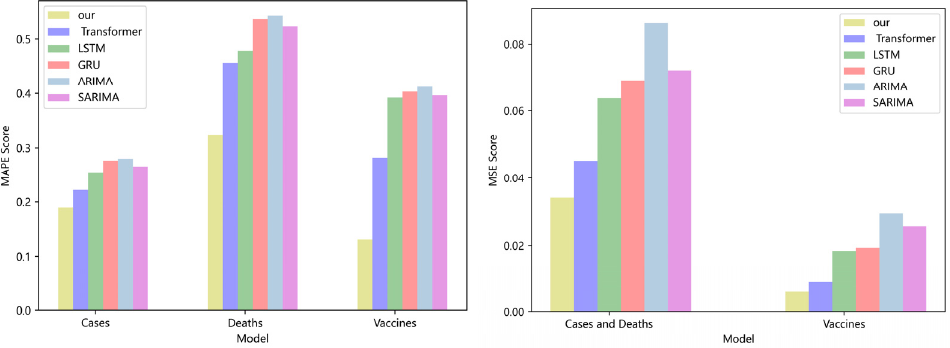
Figure 4. Comparison of MAPE and MSE score for NY cases, deaths, and vaccines.